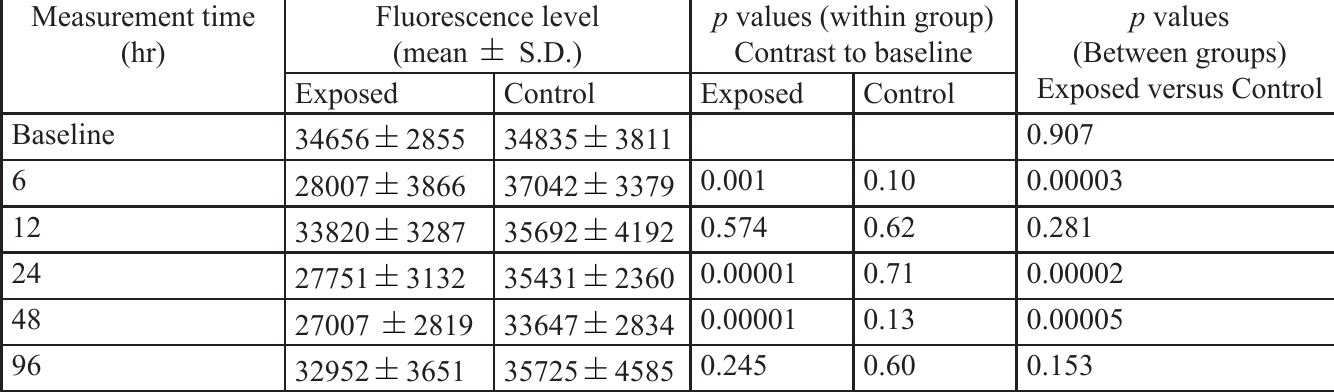
Table 2. Descriptive statistics of the fluorescence data for lenses exposed to OPTI-FREE multipurpose contact lens solution ( n = 10 for exposed lenses, and n = 10 for control lenses).